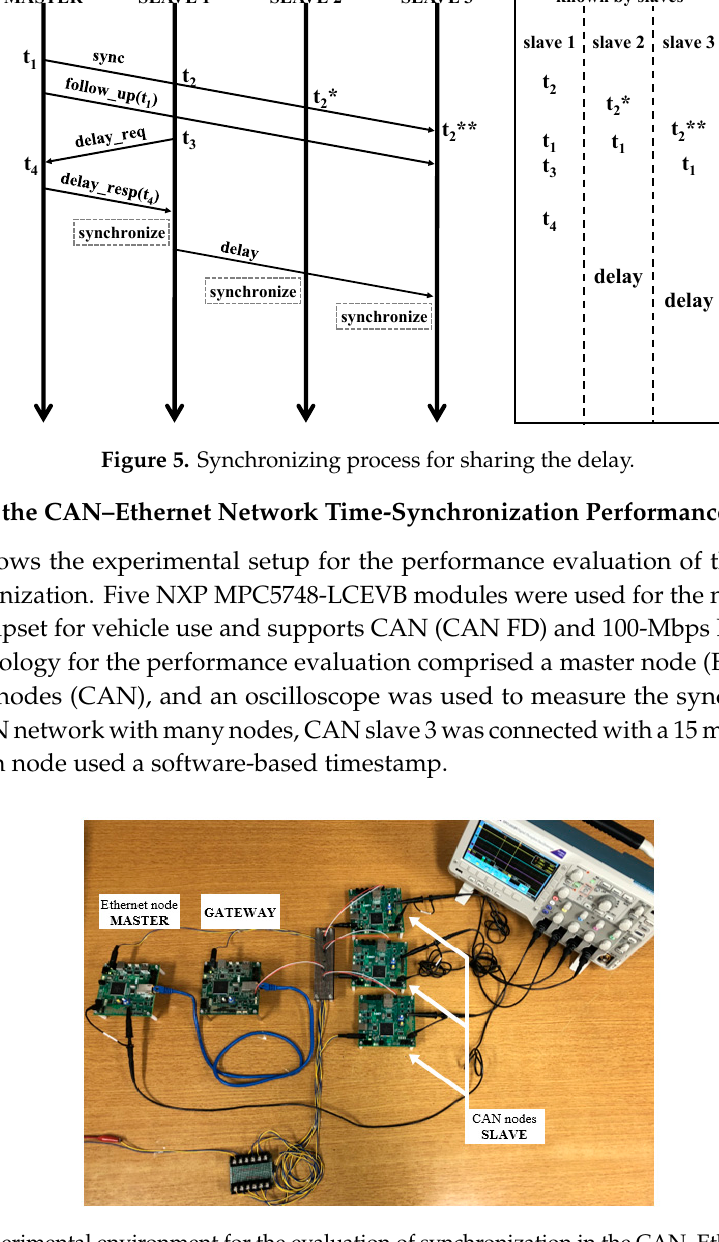
Figure 6. Experimental environment for the evaluation of synchronization in the CAN–Ethernet network.